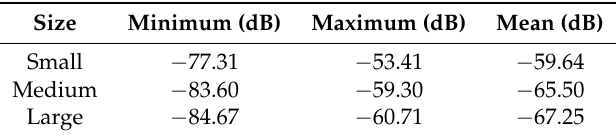
Table 4. The IL for the Three House